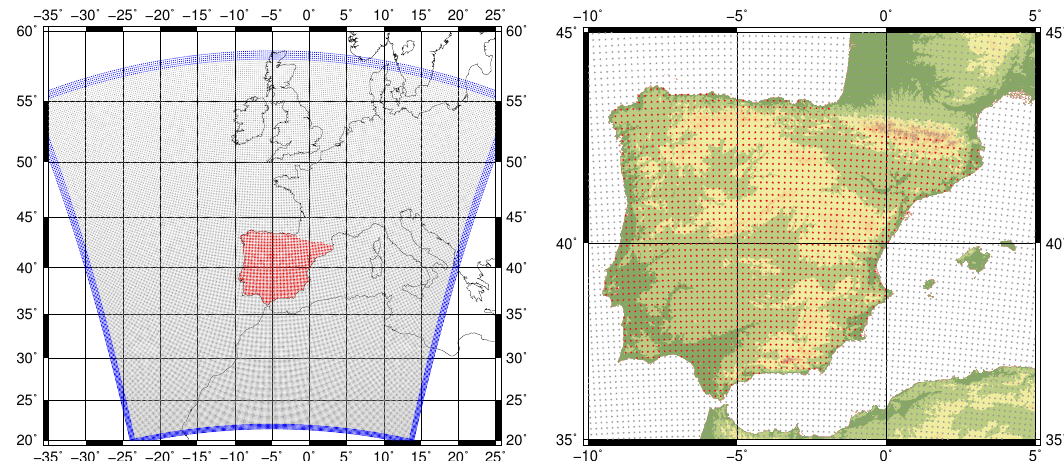
Figure 1. Left: The domain of both experiments is marked with grey dots, and the relaxation zone for the model is highlighted in blue. Right: The mask defined for the IP is defined in red (also in left panel) over the topography of the region, as represented in the ETOPO1 dataset